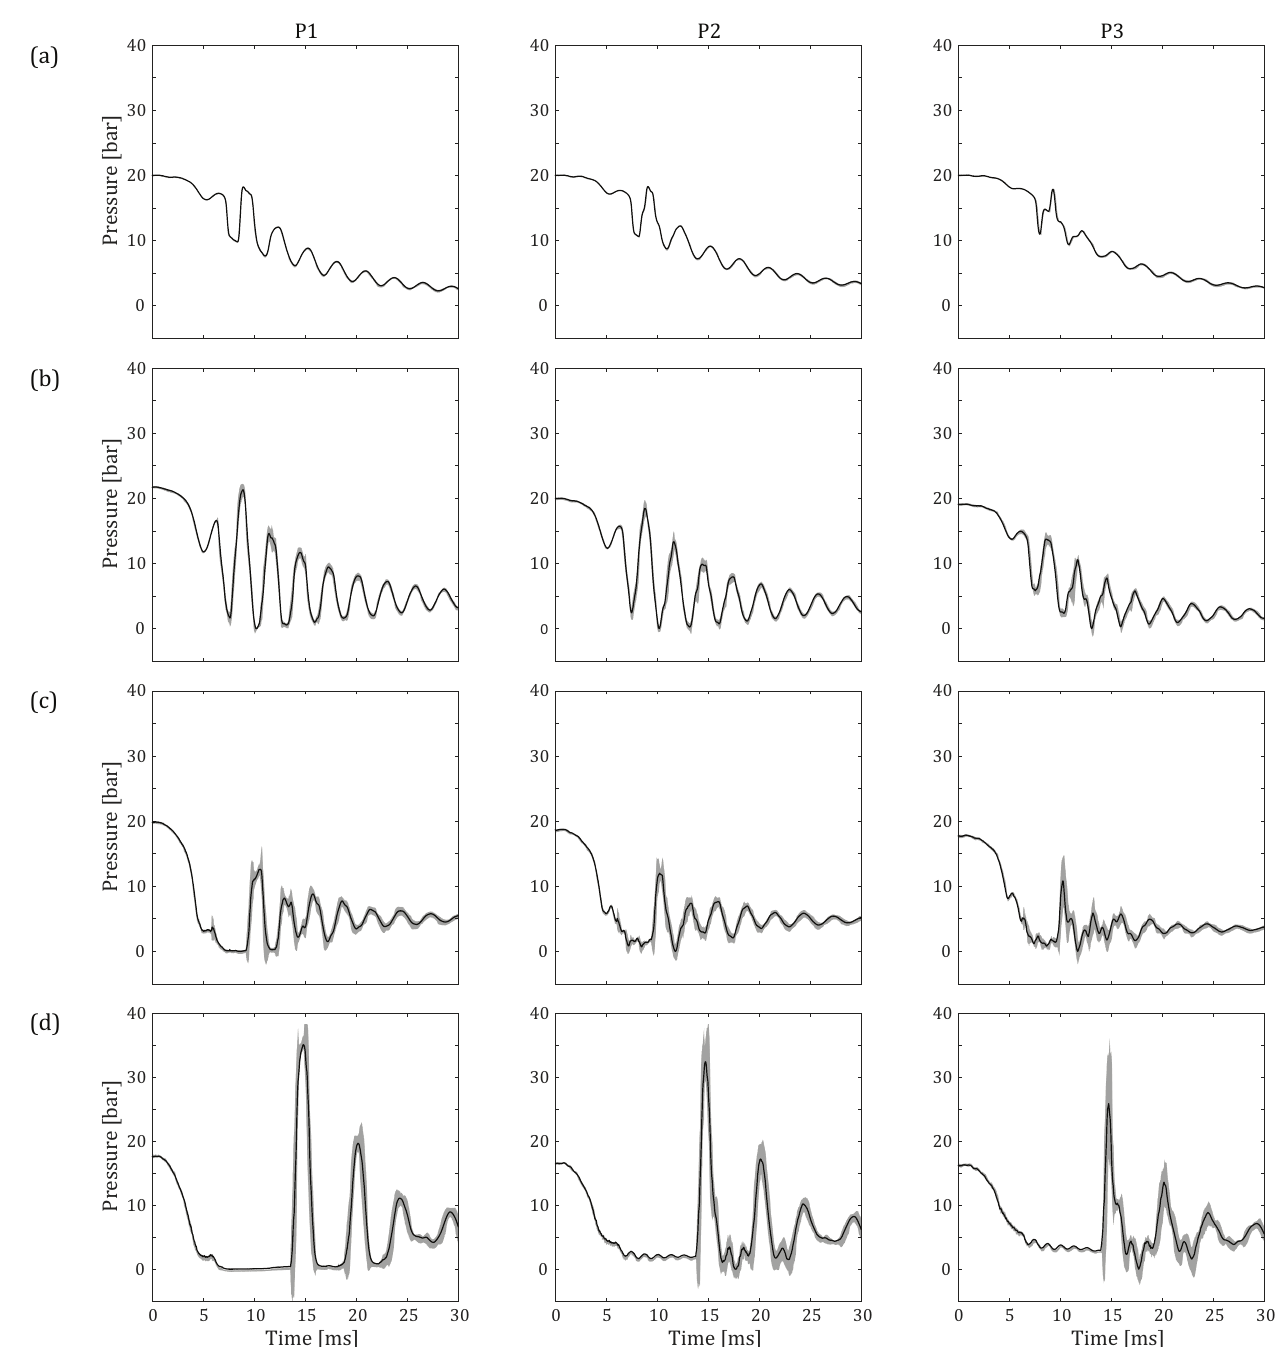
Figure 4. Ensemble-averaged pressure (black) and standard deviation (grey) in the pipe for N = 10 tests. Pressure sensors P1, P2, and P3 were located at 20 mm, 220 mm, and 420 mm from the contraction, respectively. Average flow rates corresponds to Reynolds numbers ( a ) Re = 465, ( b ) Re = 1000, ( c ) Re = 1633, and ( d ) Re =